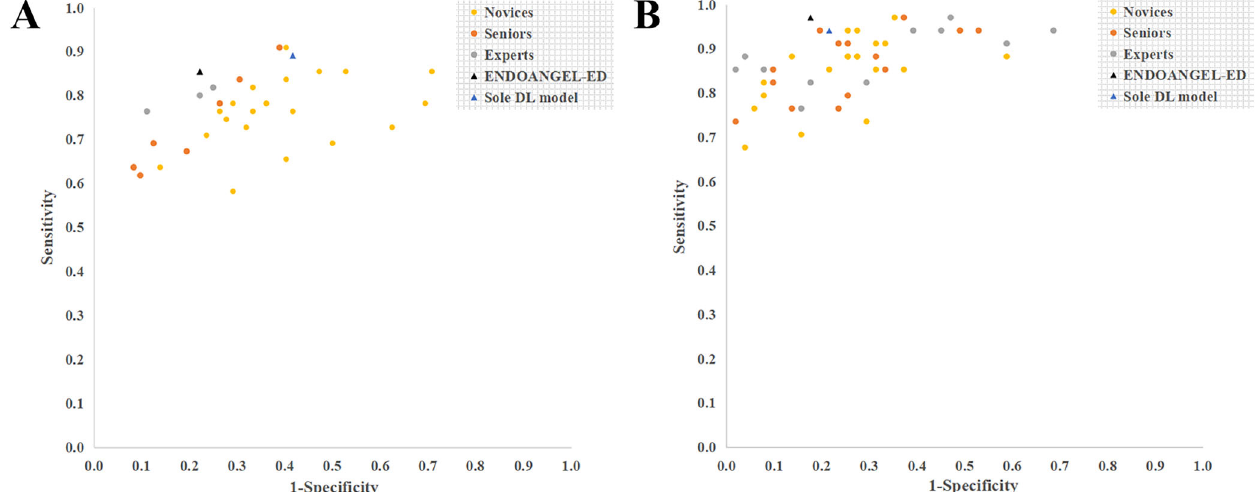
Fig. 4 The system interface of ENDOANGEL-ED. The prediction of the six-feature indexes and the diagnostic result are presented on the